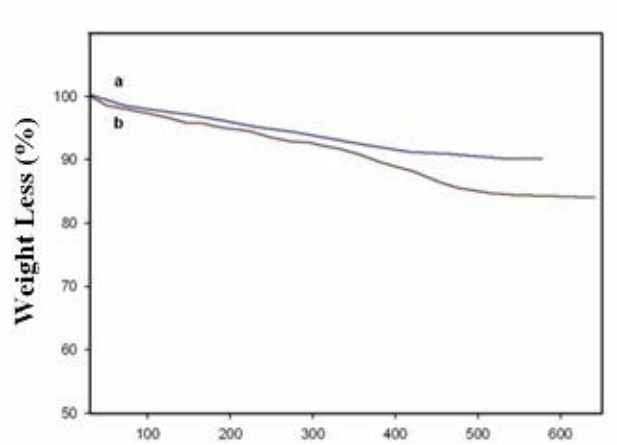
Fig. 1. The FT-IR of the Catalyst.